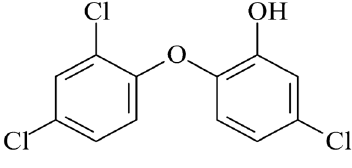
Figure 3. Molecular structure of triclosan.